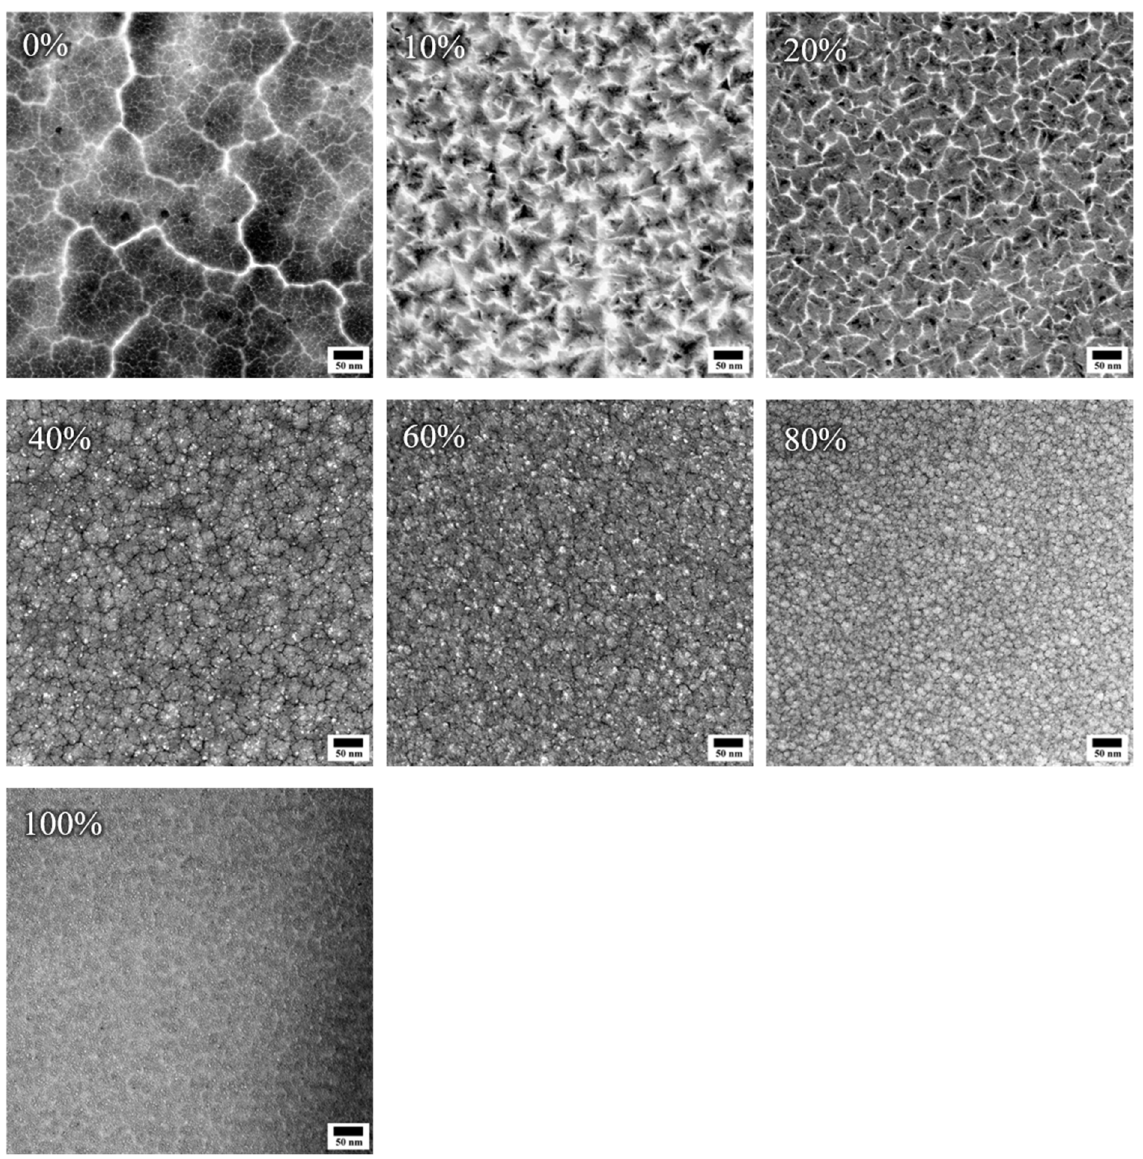
Figure 6. TEM images of (CrHfNbTaTiVZr)N coatings deposited at various R N .